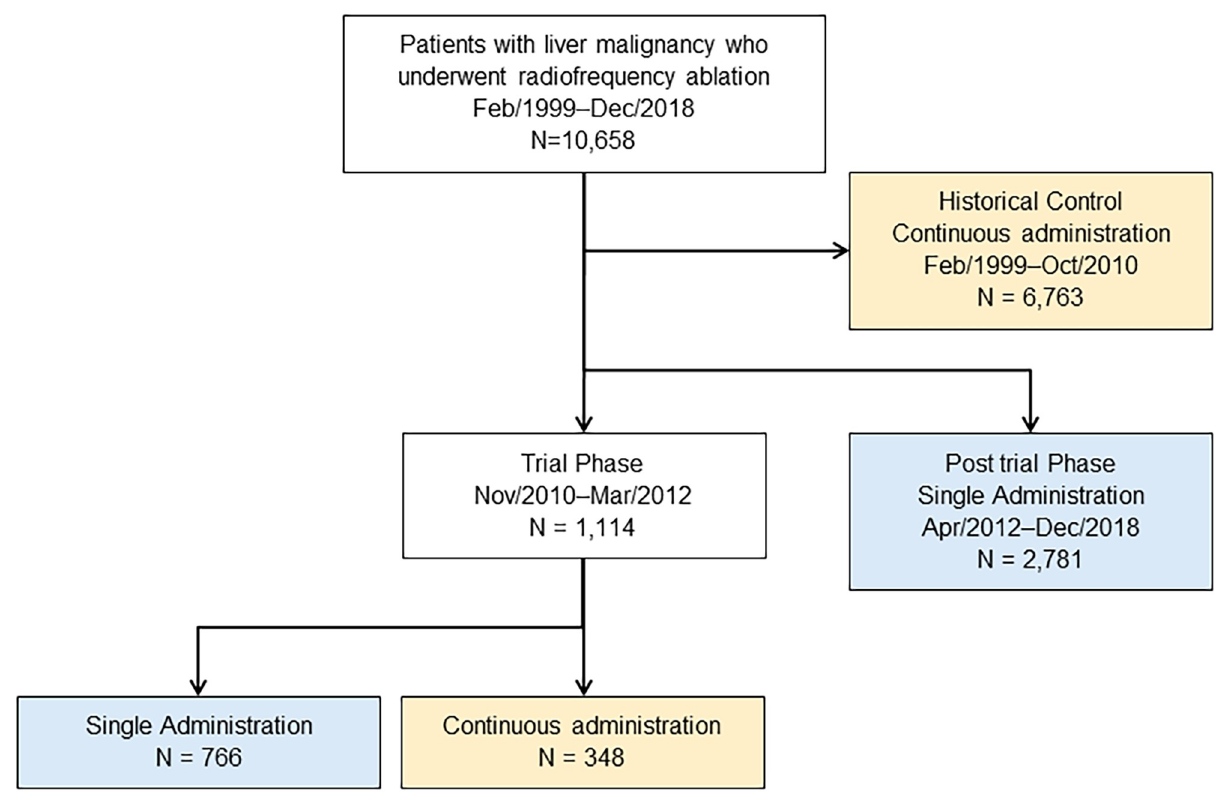
Fig 1. Participant flow